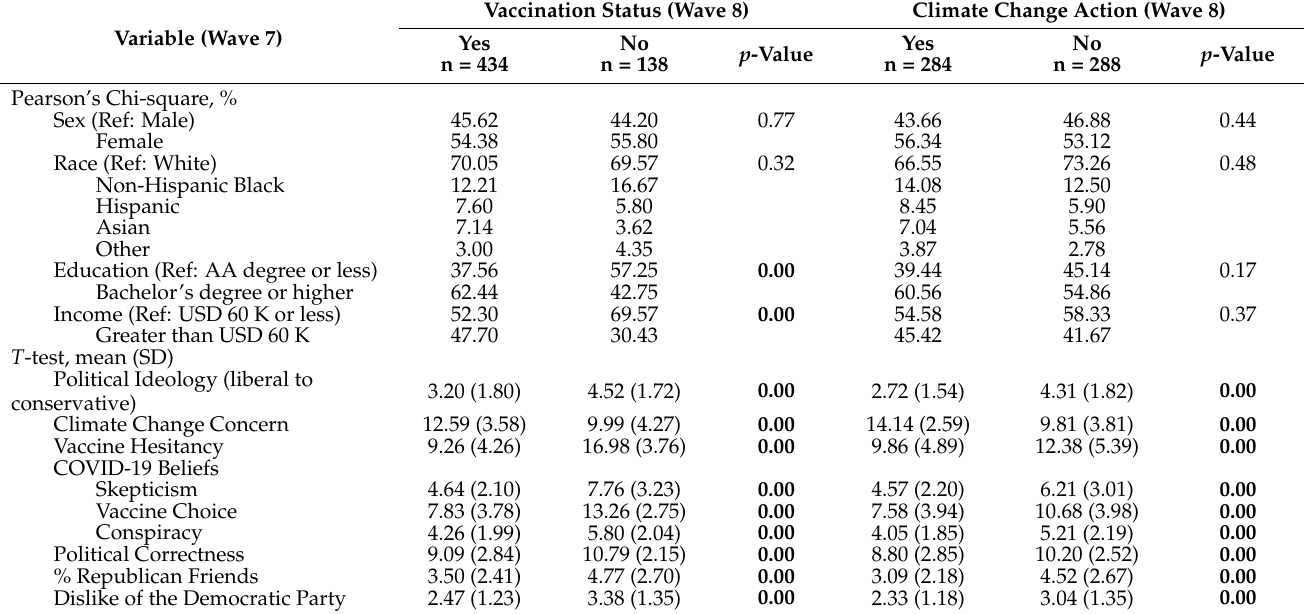
Table 4. T -tests and chi-square models of vaccination and climate change attitudes and behaviors at wave 7 and wave 8—behavioral outcomes. Bold = p <